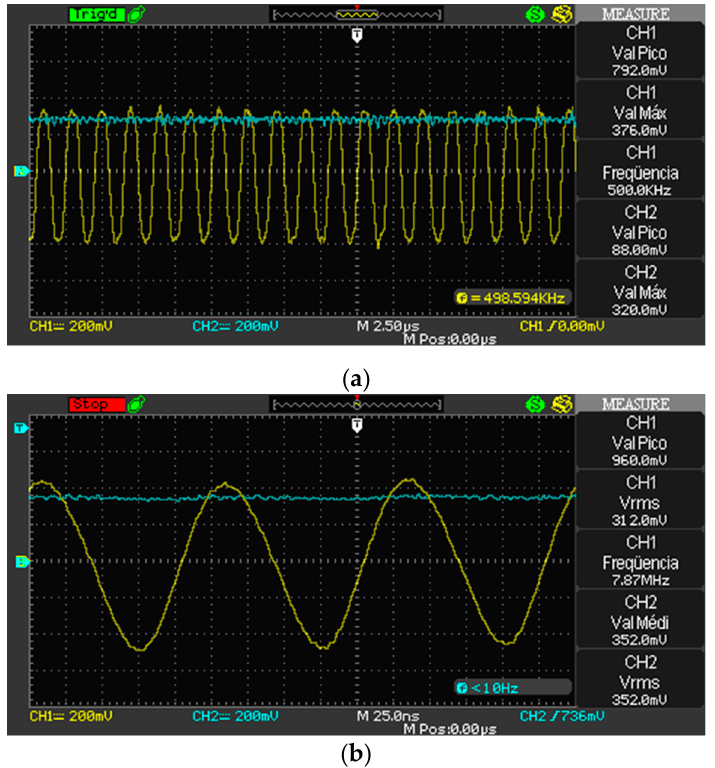
Figure 5. (a) 500 kHz and rectified signal; (b) 8 MHz and rectified signal. Figure 5. ( a ) 500 kHz and rectified signal; ( b ) 8 MHz and rectified